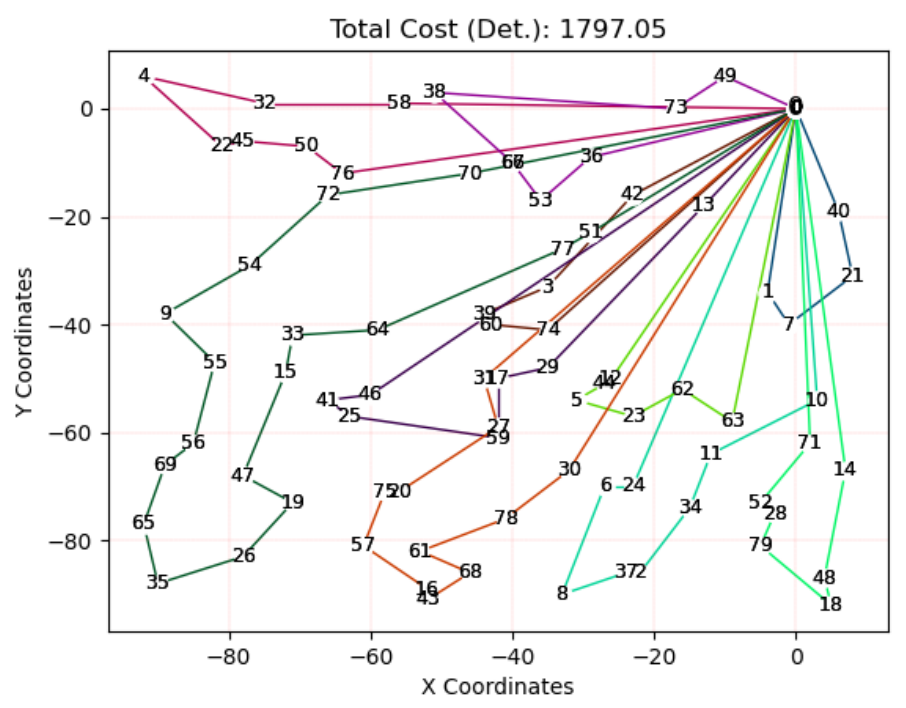
Figure 10. Best solution for VRP-Deterministic scenario.